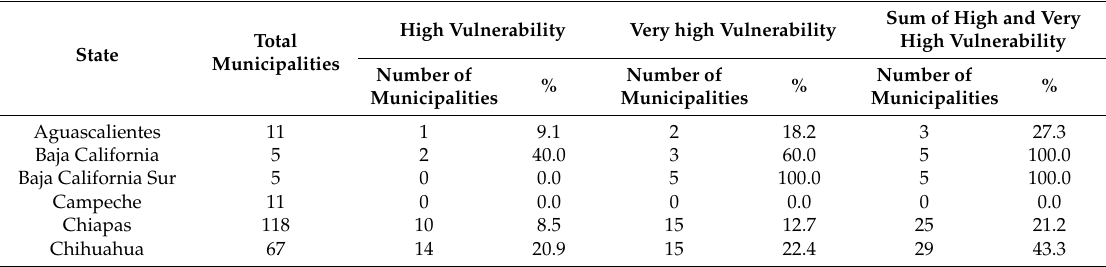
Table A5. Overall vulnerability. Number of municipalities by state and percentages of municipalities with high and very high overall vulnerability by